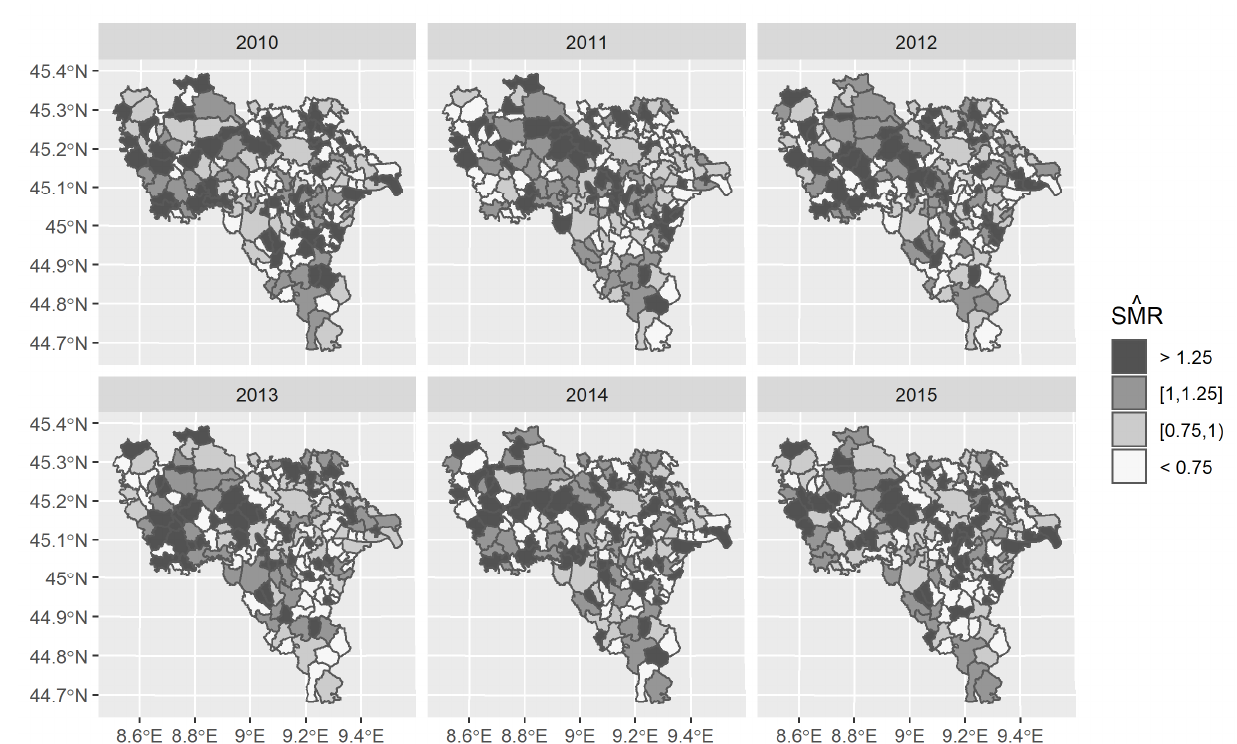
Figure 4. Spatio-temporal distribution of crude standardised mortality ratios (SMR) (maximum likelihood estimates from Poisson assumption).